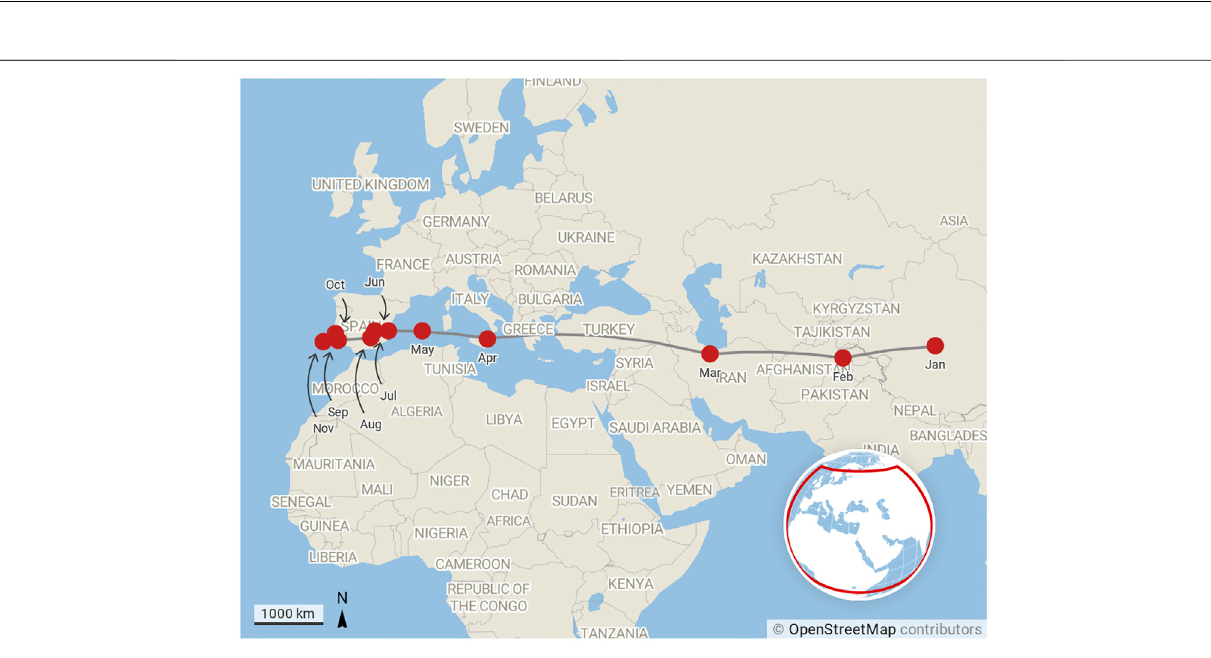
Frontiers in Research Metrics and Analytics |